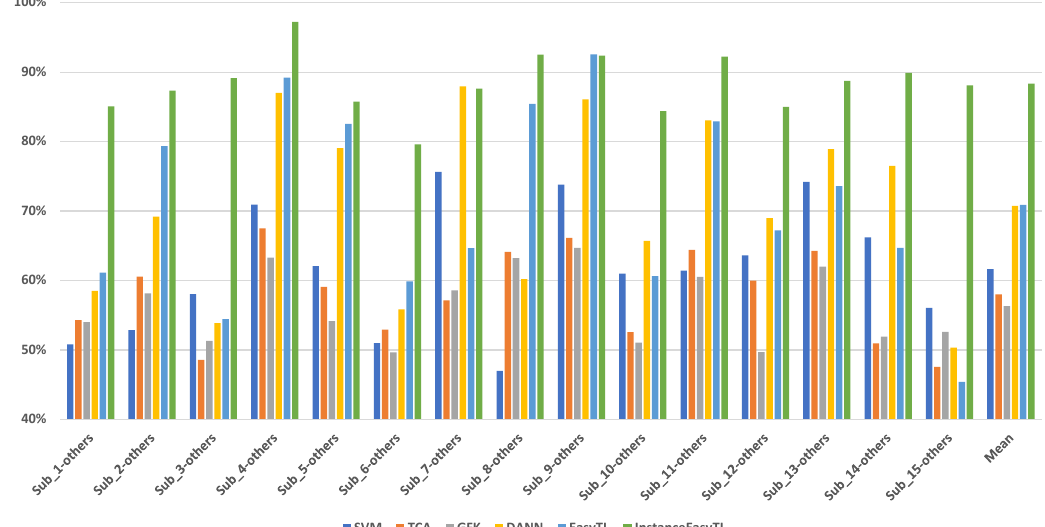
Figure 9. Classification accuracy comparison. X axis is represented as Sub_i-others (i = 1, 2, ..., 15), where Sub_i is the samples of target domain, others are the samples of source domain. For example, the samples of “Sub_1” are used as the target domain, and those of the other 14 subjects are represented as “others” as the source domain. Y axis shows classification accuracy of InstanceEasyTL and other methods used for